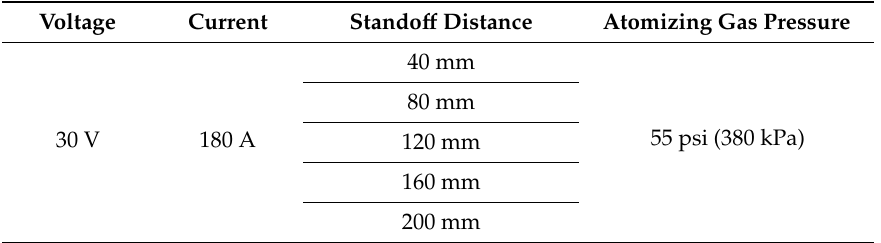
Table 1. Parameters used for ASP.